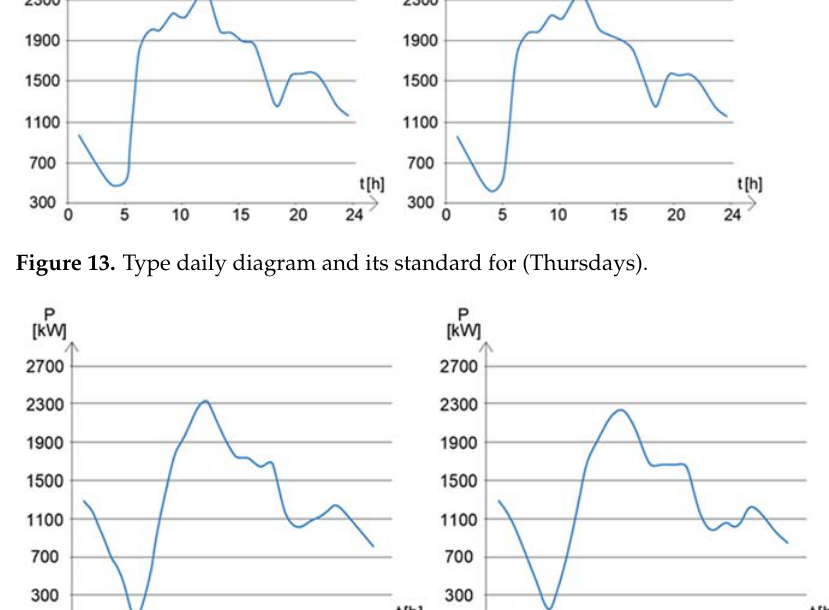
Figure 14. Type daily diagram and its standard for (Saturdays).